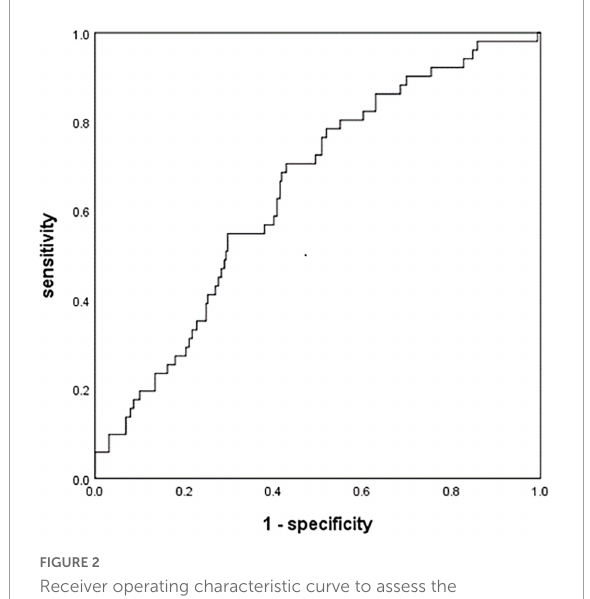
foam cells (Kundi et al., 2016). At the same time, HDL can recruit new endothelial cells to injured vascular